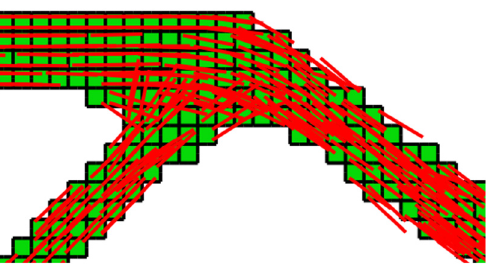
Figure 12. Example of optimized material orientation within the reinforcement structure. The blue lines indicate the material orientation which follows the direction of the absolute maximum principal stress.